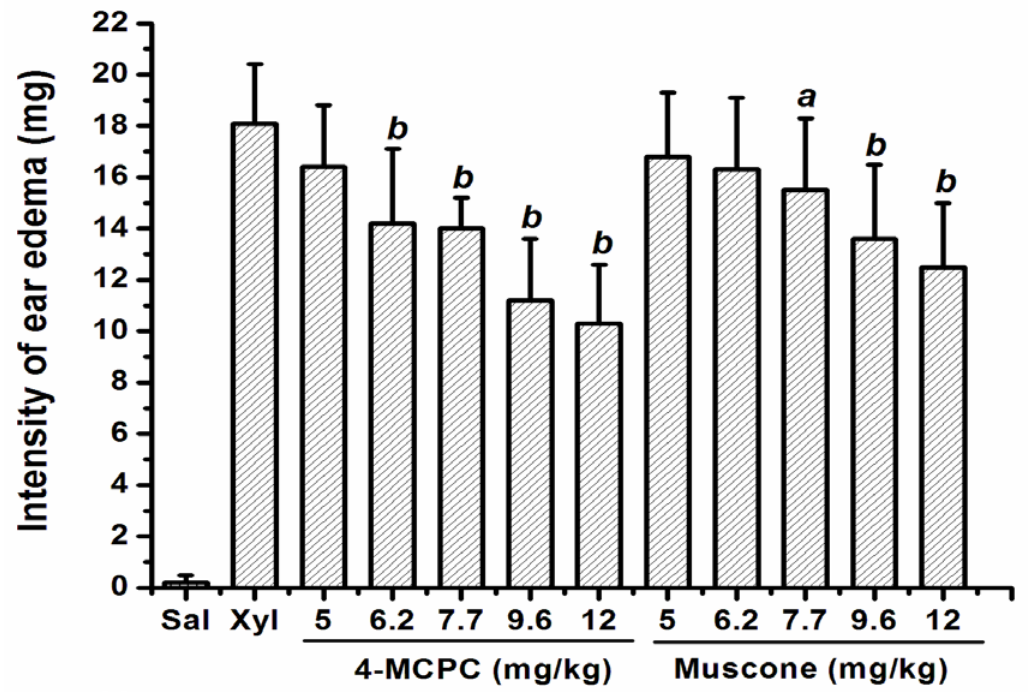
Figure 1. Effects of 4-MCPC and muscone on xylene-induced mouse ear edema. Administration of 4-MCPC (12.0, 9.6, 7.7 and 6.2 mg/kg) and muscone (12.0, 9.6 and 7.7 mg/kg), respectively, reduced ear edema. Bars represent mean ± SD for each group, n = 10. a p < 0.05; b p < 0.01 versus xylene model group. Sal: saline; Xyl: